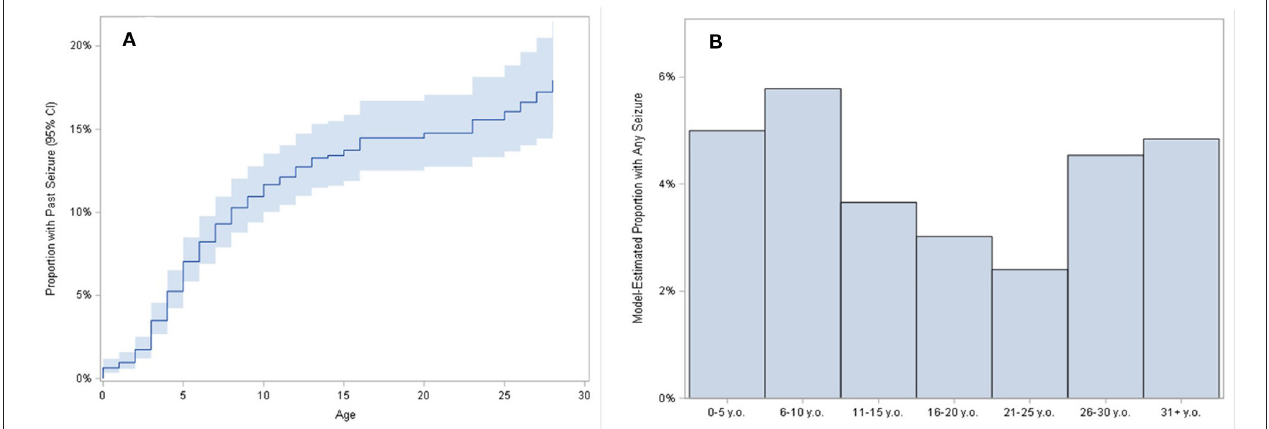
FIGURE 4 | Plot of time to first seizure. (A) Reverse Kaplan–Meier estimates show the estimated proportion of subjects who had their first seizure onset reported, over ages 0 to 30. Band shows 95% confidence intervals for estimates. For example, approximately 7% of subjects had first seizure onset by age 5, approximately 12% of subjects had first seizure onset by age 10, and approximately 14% of subjects had first seizure onset by age 15. Bar chart of the model-estimated proportion of having any seizures during selected age periods (B) . Proportion estimates are derived from mixed-effect logistic regression models fit for the odds of having experienced a seizure, with categorized age as the predictor, and random intercepts for